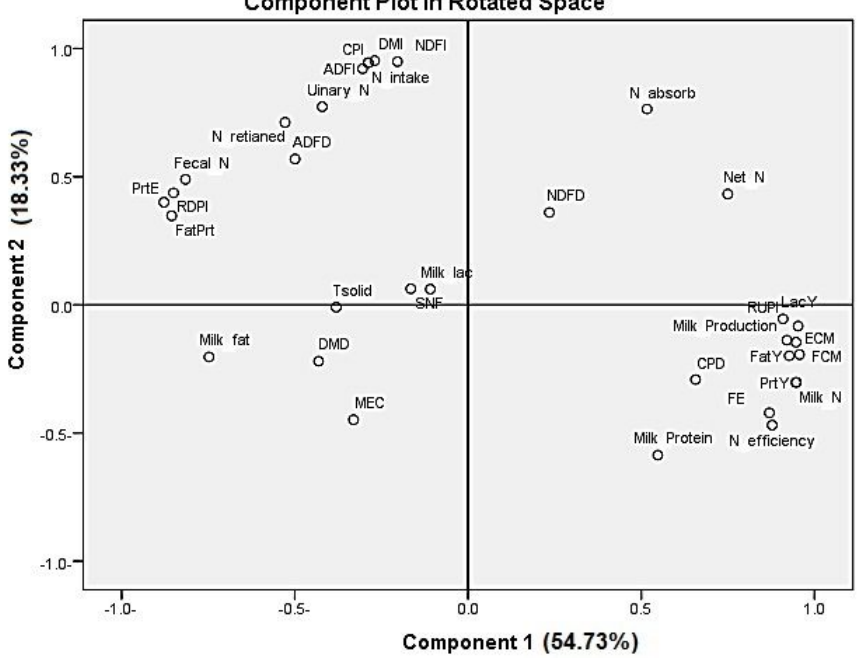
Figure 1. A plot illustrating the relationships among rumen-undegradable protein (RUP) intake, nutrient digestibility, nitrogen (N) use, and lactation performance variables. The variables are as follows: DMI, dry matter intake; CPI, crude protein intake; NDFI, neutral detergent fiber intake; ADFI, acid detergent fiber intake; RUPI, RUP intake; RDPI, rumen-degradable protein intake; DMD, dry matter digestibility; CPD, crude protein digestibility; NDFD, neutral detergent fiber digestibility; ADFD, acid detergent fiber digestibility; N intake; Fecal N; N absorbed; Urinary N; Net N; Milk N; N retained; N-use efficiency; ECM, energy-corrected milk; Milk Production; FCM, fat- corrected milk; Milk fat; Milk Protein; FatPrt, fat to protein ratio; Milk lac, milk lactose; SNF, solids not fat; Tsolid, total solids; PrtY, protein yield; FatY, fat yield; LacY, lactose yield; MEC, milk energy content (Mcal kg -1 ); FE, feed efficiency; PrtE, protein